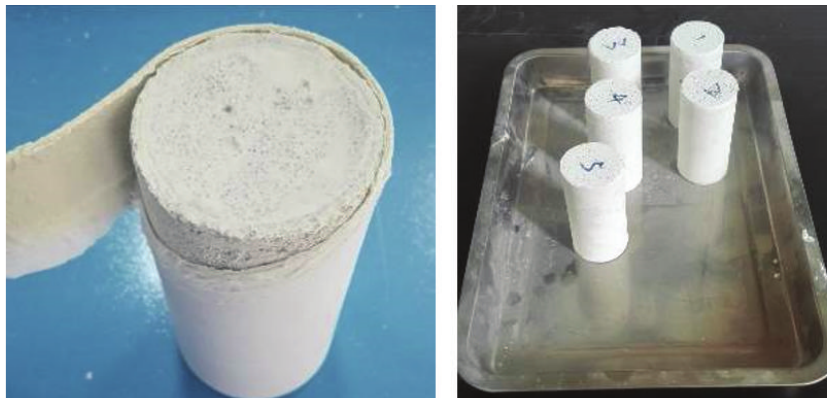
Figure 6: Stripping.